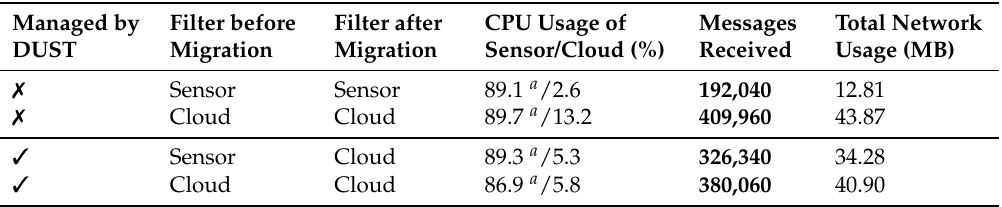
Table 3. CPU optimization of use case 1.